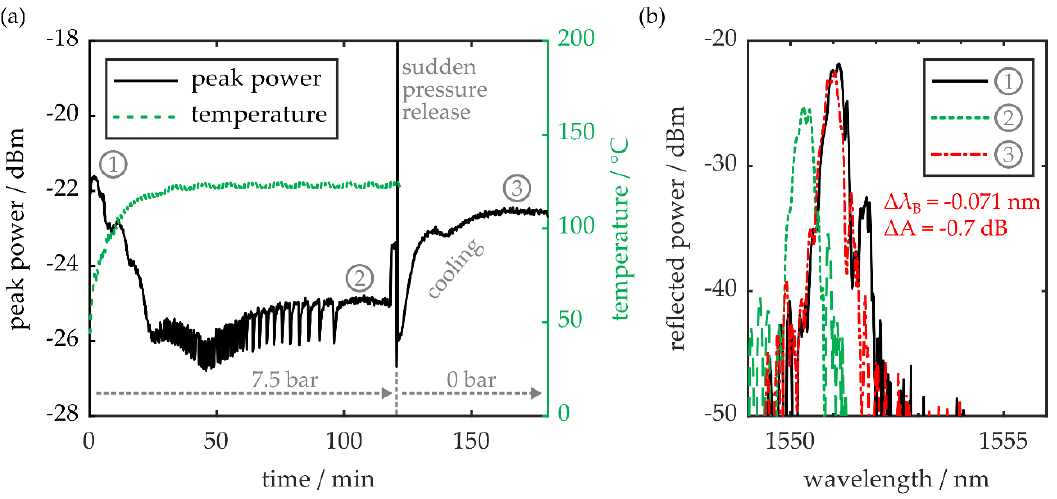
Figure 5. ( a ) Reflected peak power of the PPBG and temperature of the mechanic press during a heated pressure cycle. ( b ) Reflection spectra at room temperature and a pressure of 0 bar 1 (cid:79) , at a temperature of 120 ◦ C and a pressure of 7.5 bar 2 (cid:79) , and after removal of the sensor from the heated press, cooled back down to room temperature 3 (cid:79)